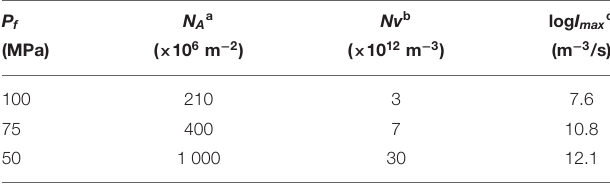
TABLE 2 | Plagioclase number density and maximum nucleation